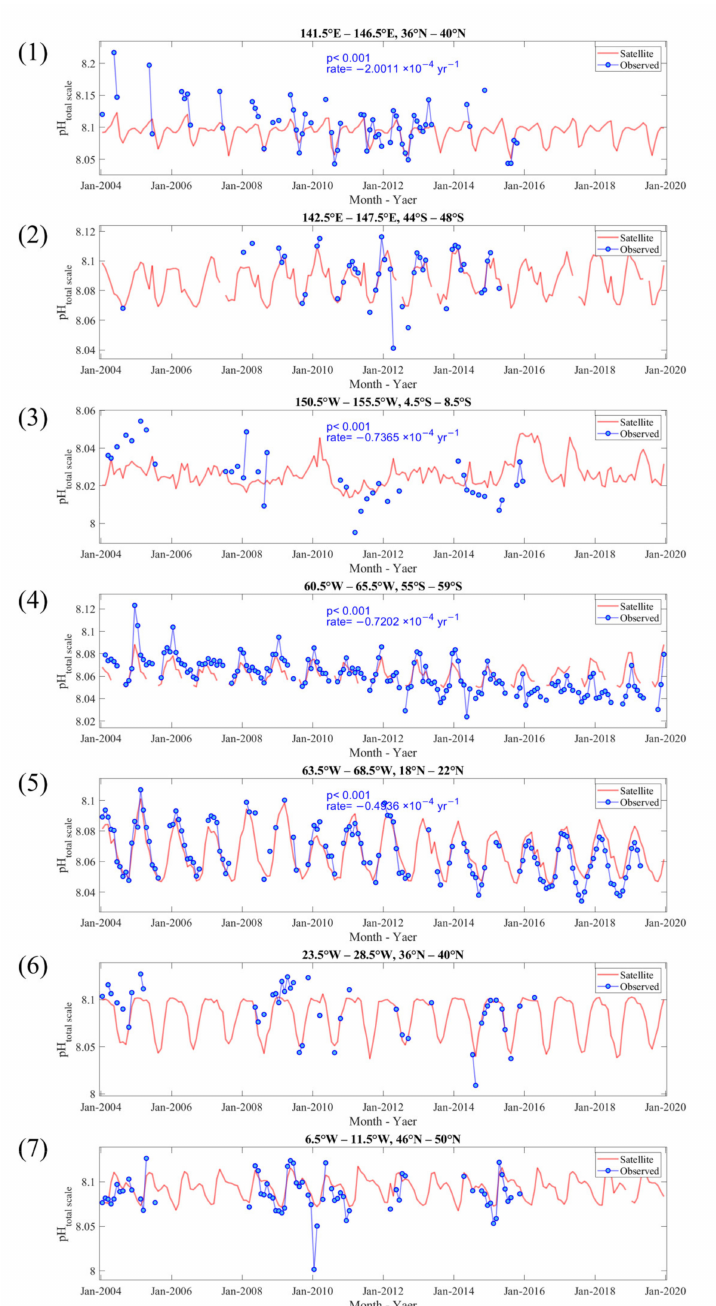
Figure 16. Seasonal variation of sea surface pH in seven typical regions with locations marked in Figure 15 and noted in Table 6: ( 1 ) northwest Pacific Ocean, ( 2 ) south of Australia, ( 3 ) equatorial Pacific Ocean, ( 4 ) south of South America, ( 5 ) north of Puerto Rico, ( 6 ) mid North Atlantic Ocean, and ( 7 ) northeast Atlantic Ocean. The red lines are the satellite-derived pH. The blue dot is the pH ( in situ *); when the p < 0.1, the rate of change is marked in blue text. All points are the results of monthly averaging under a 4 ◦ × 5 ◦